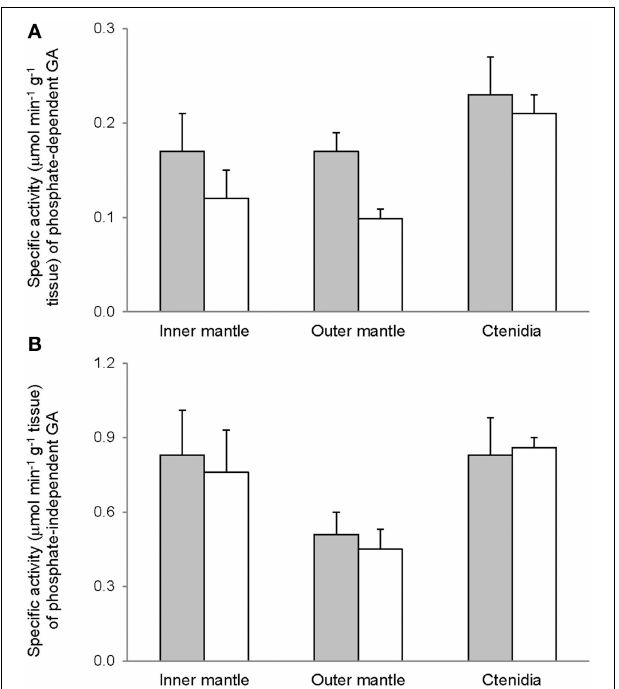
FIGURE 8 | Mass-specific activity ( µ mol Pi min − 1 g − 1 tissue + S.E.M.; N = 4 ) of (A) phosphate dependent glutaminase (GA) (B) phosphate independent GA from the inner mantle, the outer mantle, and ctenidia of Tridacna squamosa exposed to 12h of darkness (control; closed bar) or 12h of light (open bar). Values represent means + S.E.M. ( N = 4 ).